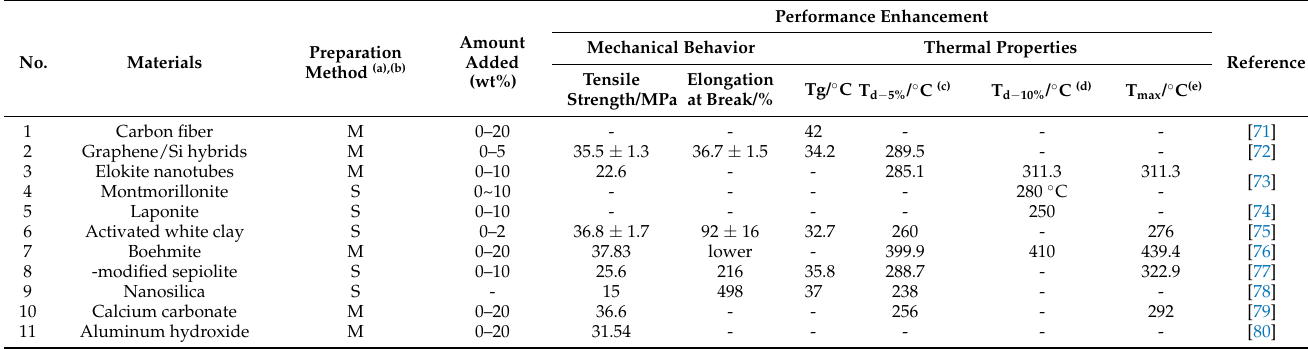
Table 6. Modified materials and enhanced